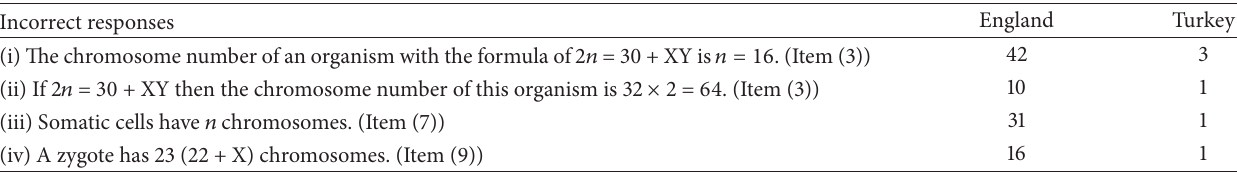
Table 4: Incorrect responses of students (more than 10%), which were not considered as alternative conception. Incorrect